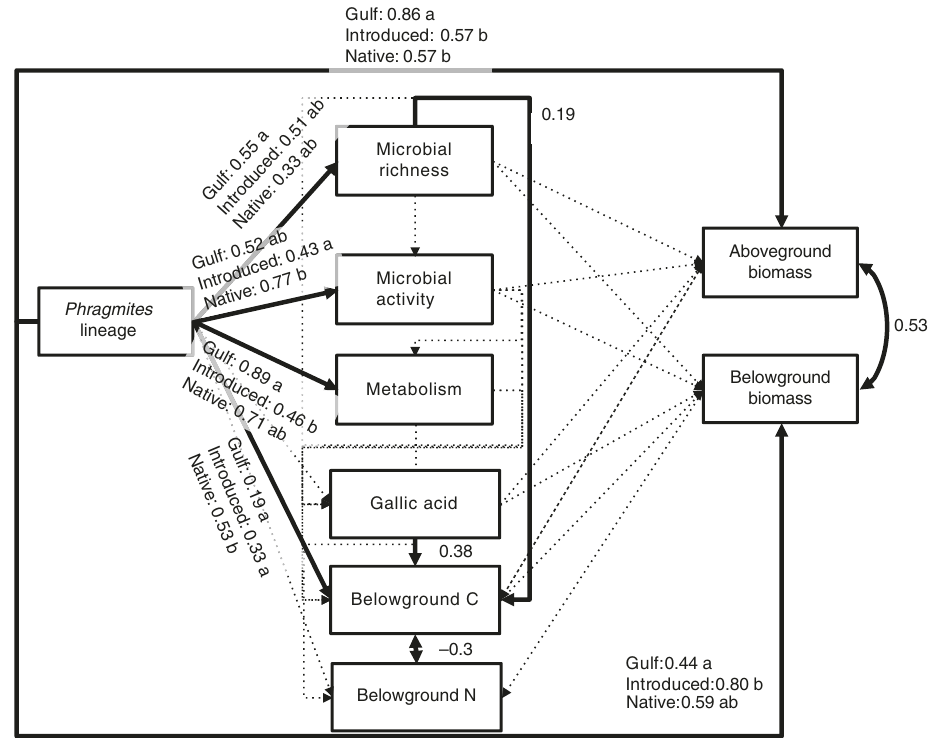
Fig. 5 Structural Equation Model fi tted with range-standardized coef fi cients. Solid lines indicate that the driver in fl uences the likelihood of the model via a χ 2 Likelihood ratio test. Dashed paths indicate no detectable in fl uence of the driver ( p > 0.05). Standardized coef fi cients are presented for each path. Letters a and b denote groupings via post-hoc tests. χ 2 test statistics can be found in Supplementary Tables 5 and